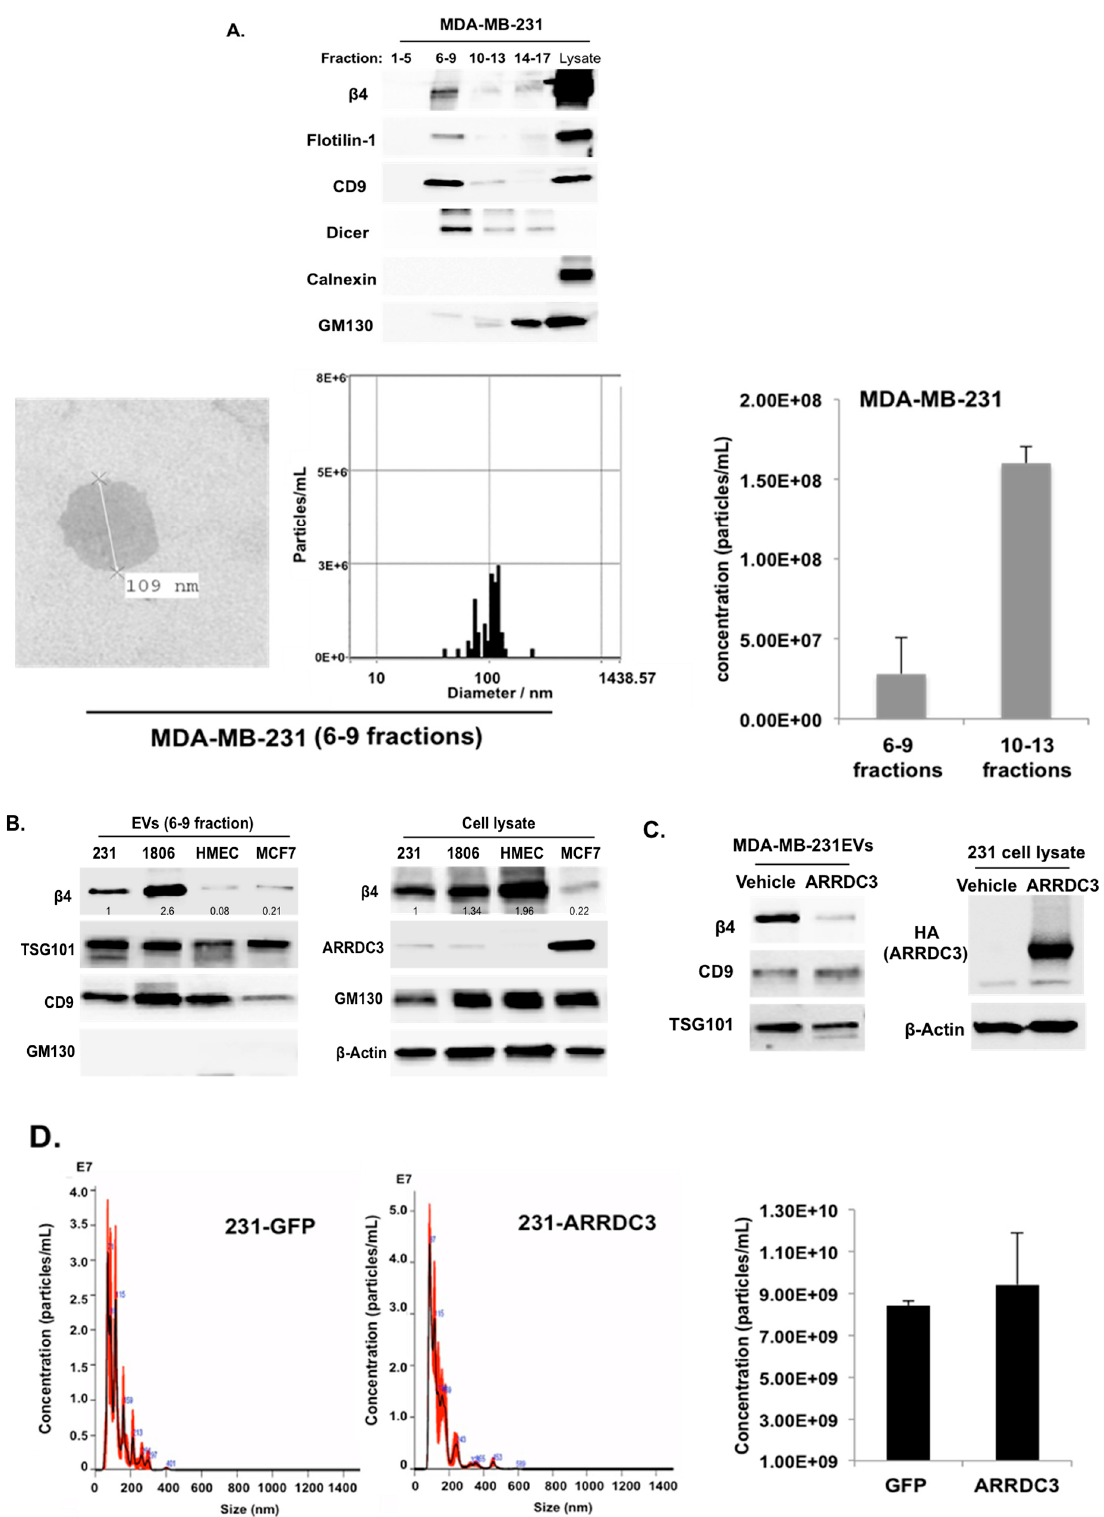
Figure 5. ARRDC3 prevents the sorting of ITG β 4 into extracellular vesicles (EVs) without affecting overall EV secretion from TNBC cells. ( A ) EVs were isolated from MDA-MB-231 cells by using qEV column (IZON). ITG β 4, exosome markers (Flotilin-1, CD9 and Dicer), non-exosome markers (Calnexin and GM-130) were analyzed by Western blot (top). Transmission electron microscope (TEM) image shows purified exosomes of MDA-MB-231 cells (bottom left). Size distribution and concentration of EVs in 6–9 fractions was measured by ZetaView (bottom right). Representative bar graph represents average concentration of selected fractions (bottom right). Data are expressed as